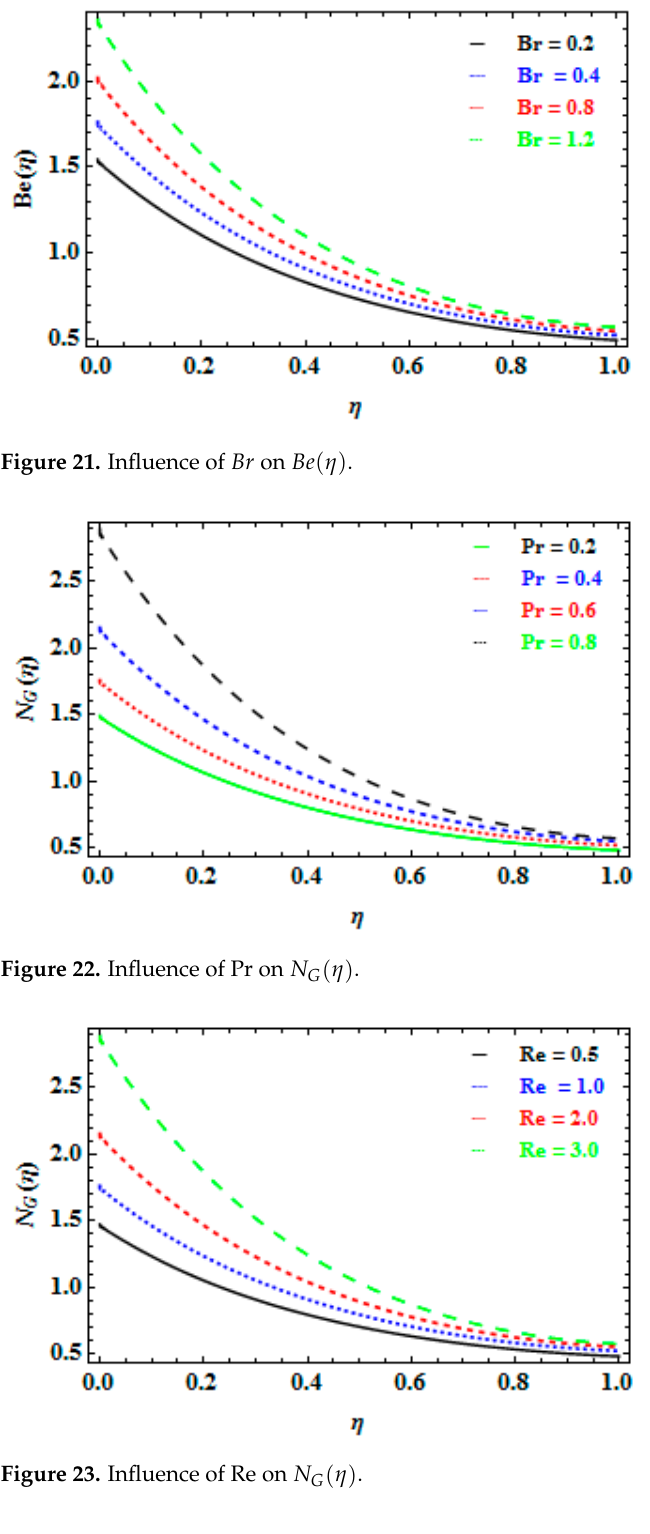
Figure 23. Influence of Re on N G ( η ).